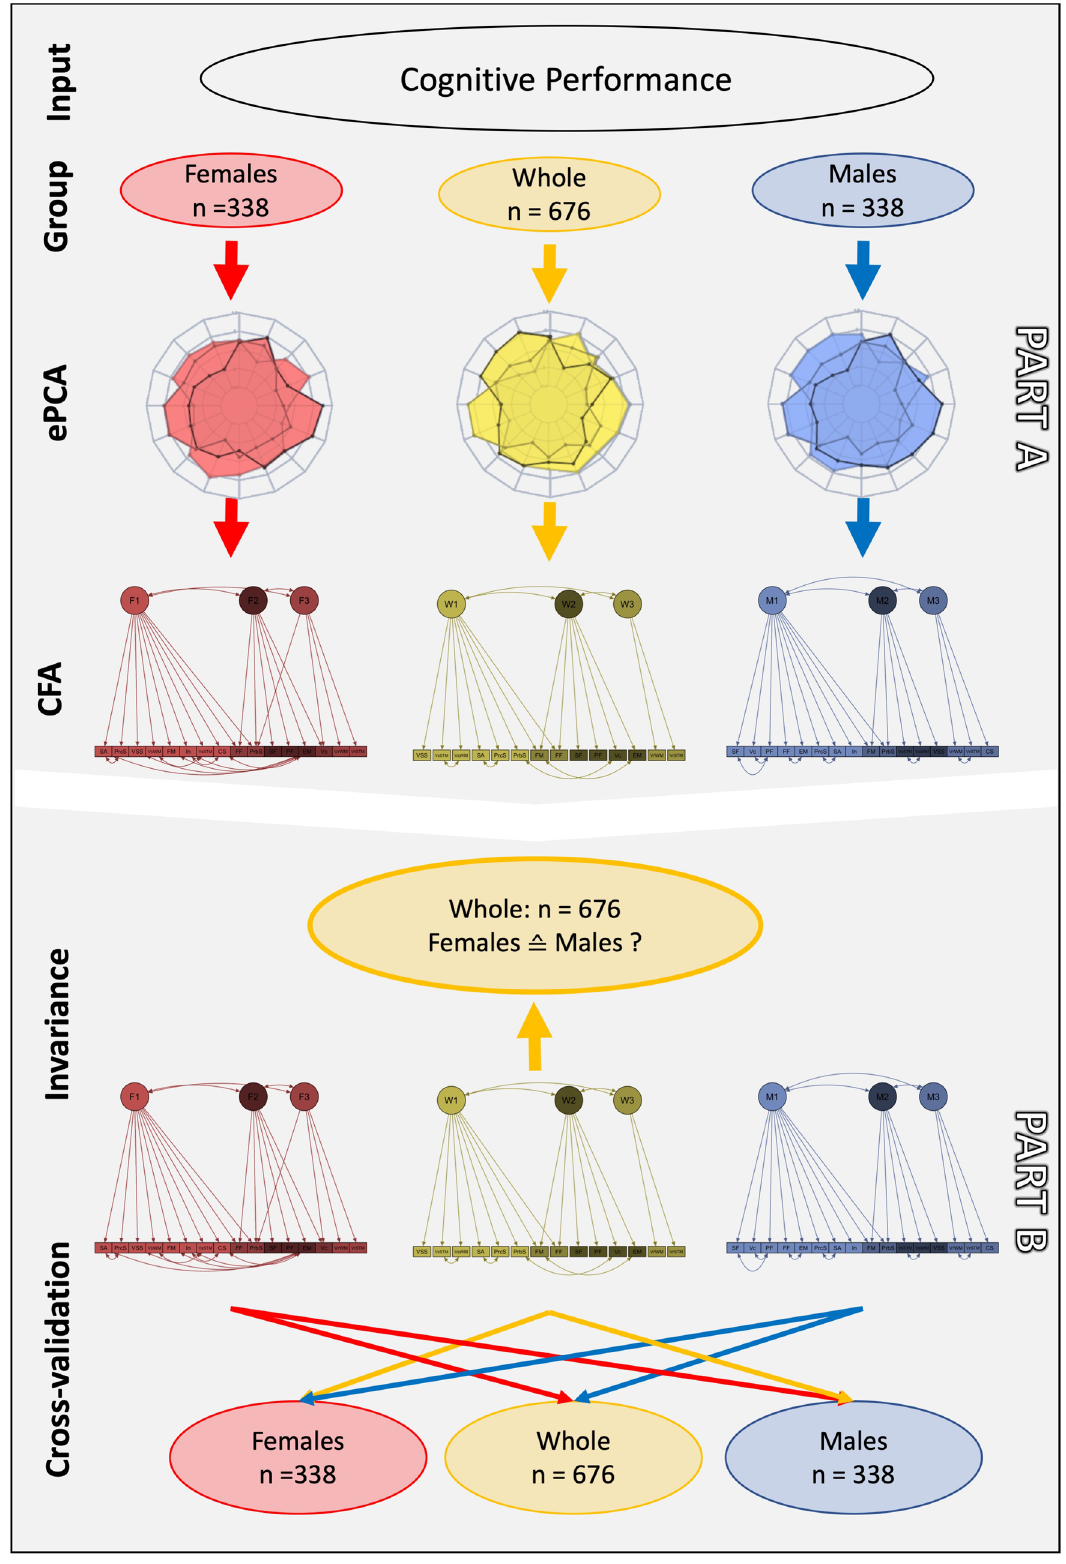
Figure 1. Flowchart presenting the study